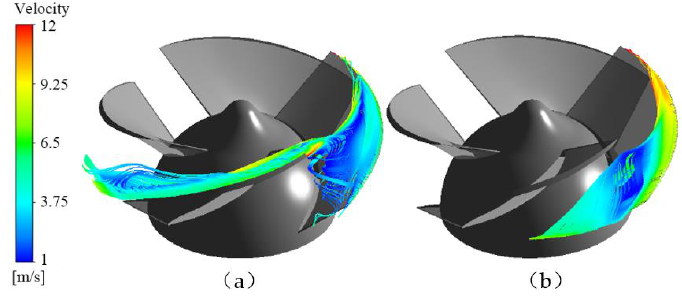
Figure 17. Form change of leakage flow ( δ = 0.2 mm).